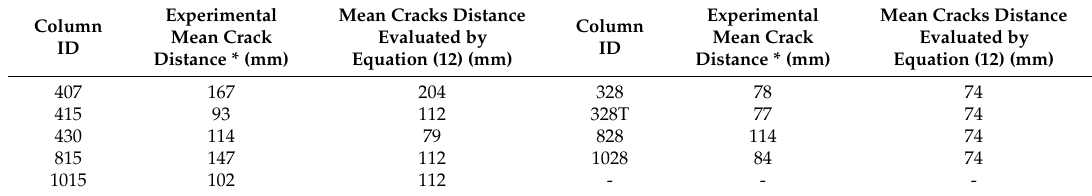
Table 3. Comparison between the experimental and numerical values of the mean crack